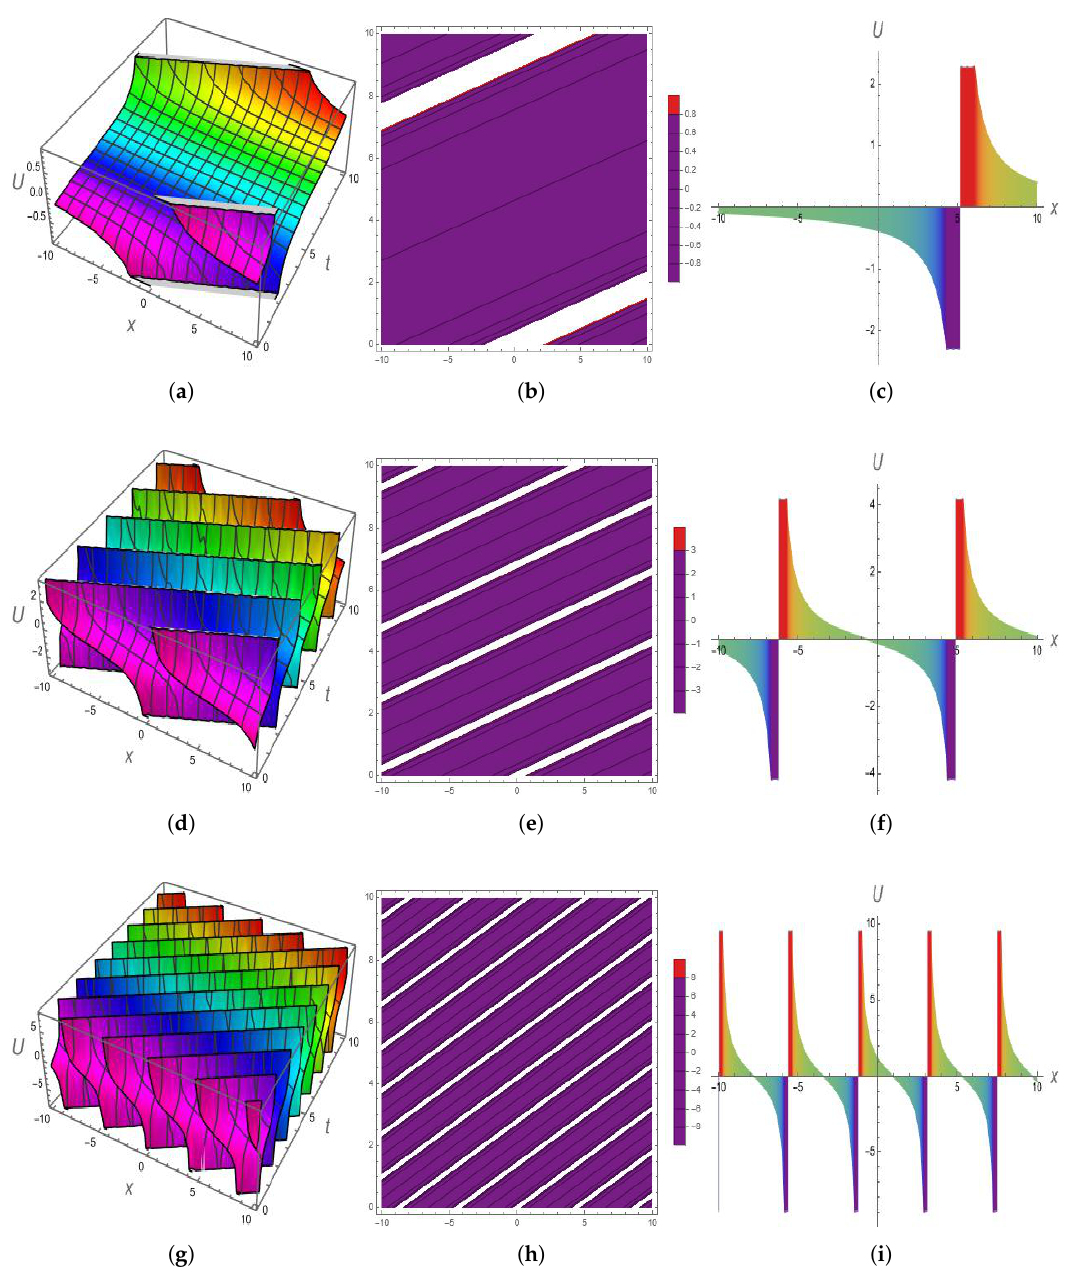
Figure 1. Three-dimensional, contour, and 2-D profiles of solution £ 3,2 for different values of pa- rameter k . ( a ) Three-dimensional propagation at k = 0.3; ( b ) Contour propagation at k = 0.3; ( c ) Two-dimensional propagation at k = 0.3; ( d ) Three-dimensional propagation at k = 1.3; ( e ) Con- tour propagation at k = 1.3; ( f ) Two-dimensional propagation at k = 1.3; ( g ) Three-dimensional propagation at k = 3.3; ( h ) Contour propagation at k = 3.3; ( i ) Two-dimensional propagation at k =